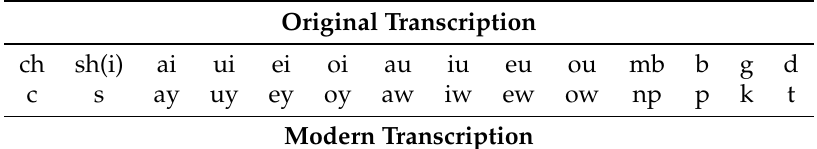
Table 1. Transcription change rules applied in part-of-speech tagger for the Ainu language (POST-AL).